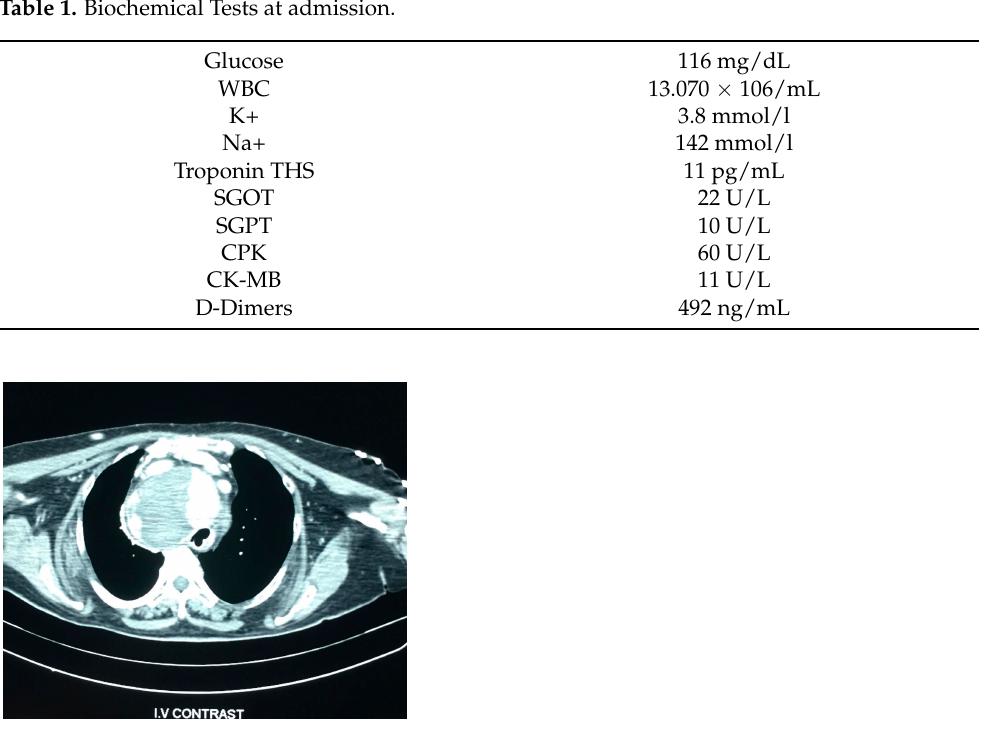
Figure 1. CT scan showing the enlarge thyroid gland and the compressed trachea shifted to the left.